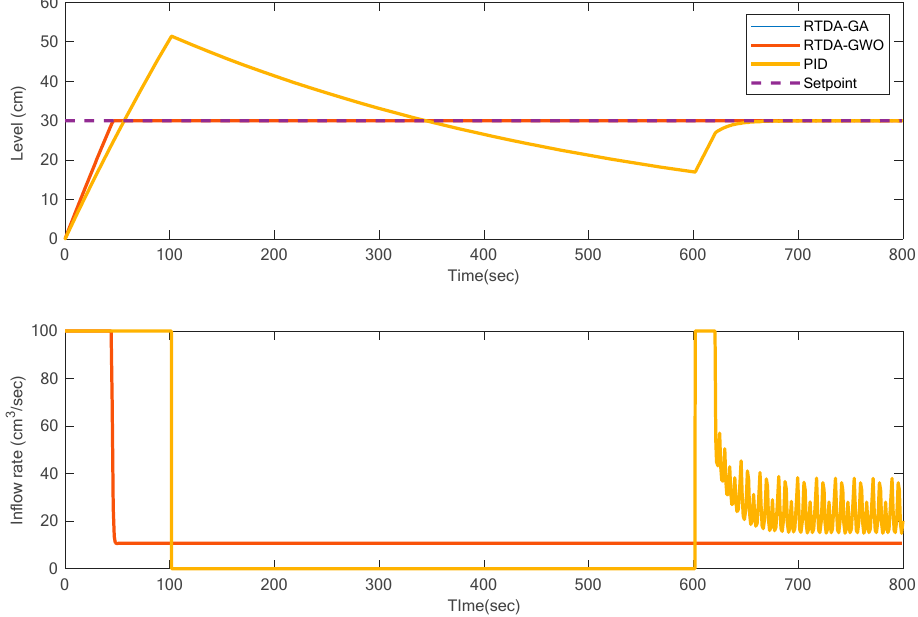
Figure 10. RTD-A and PID controlled level of conical tank for h = 30 cm.